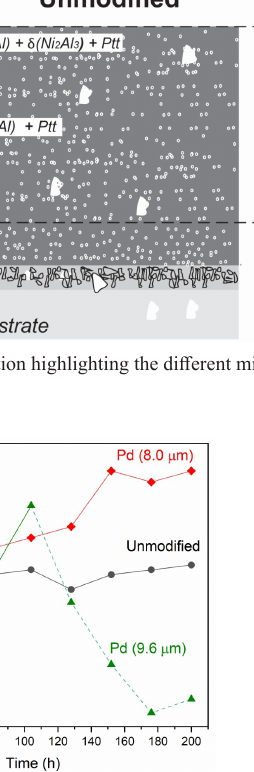
Figure 5. Morphology of Al coatings after isothermal oxidation at 1000 °C for 200 h; a) Pd- modified coating (9.6 µm); b) unmodified